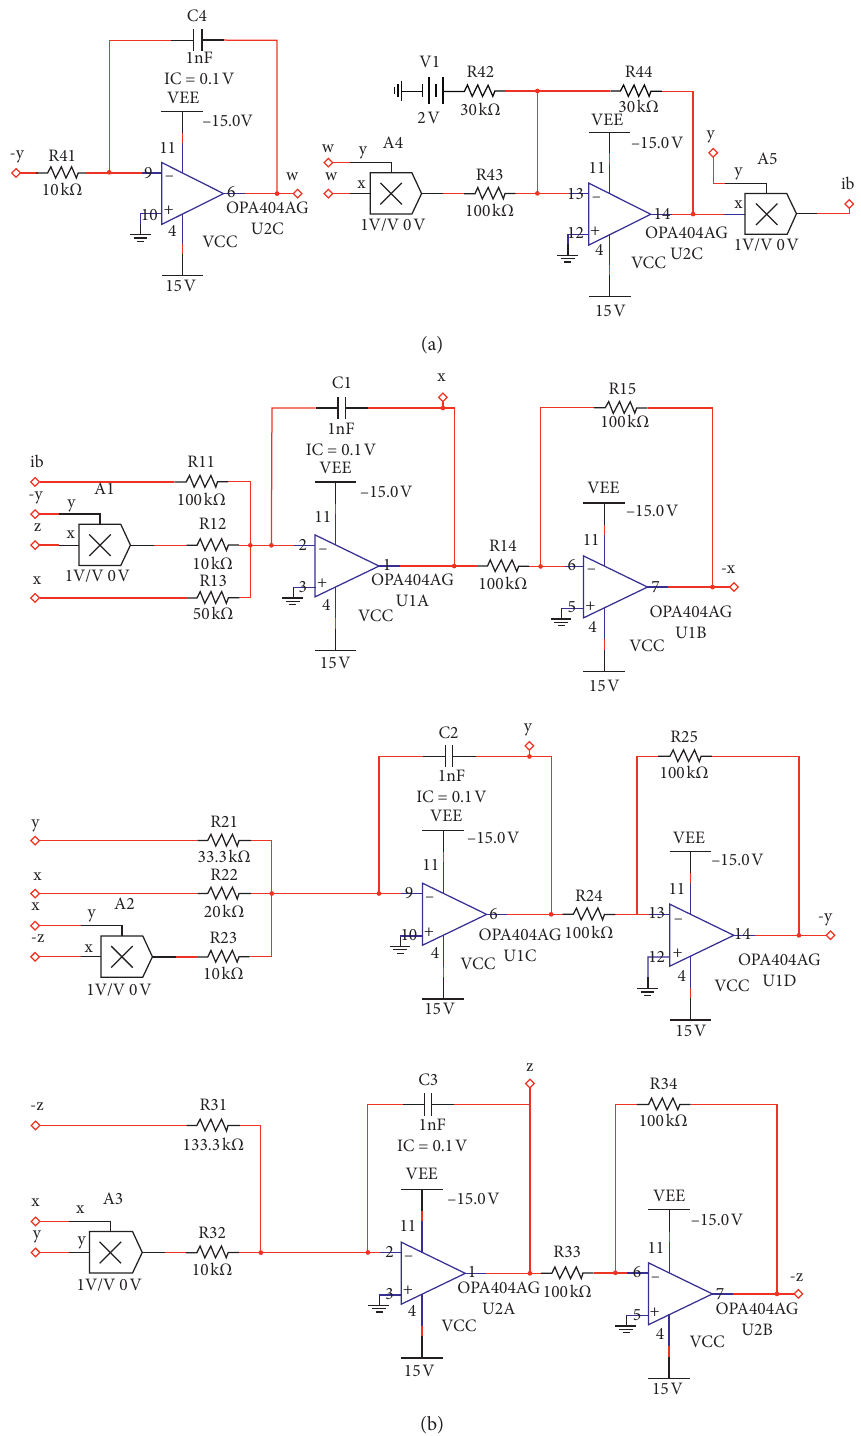
Figure 11: The analog circuit of the deformed